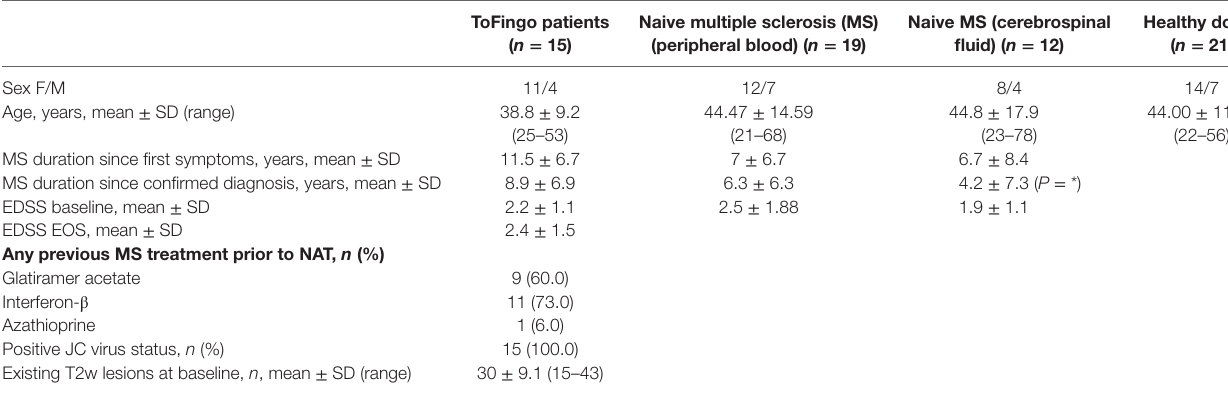
TaBle 1 | Summary of baseline